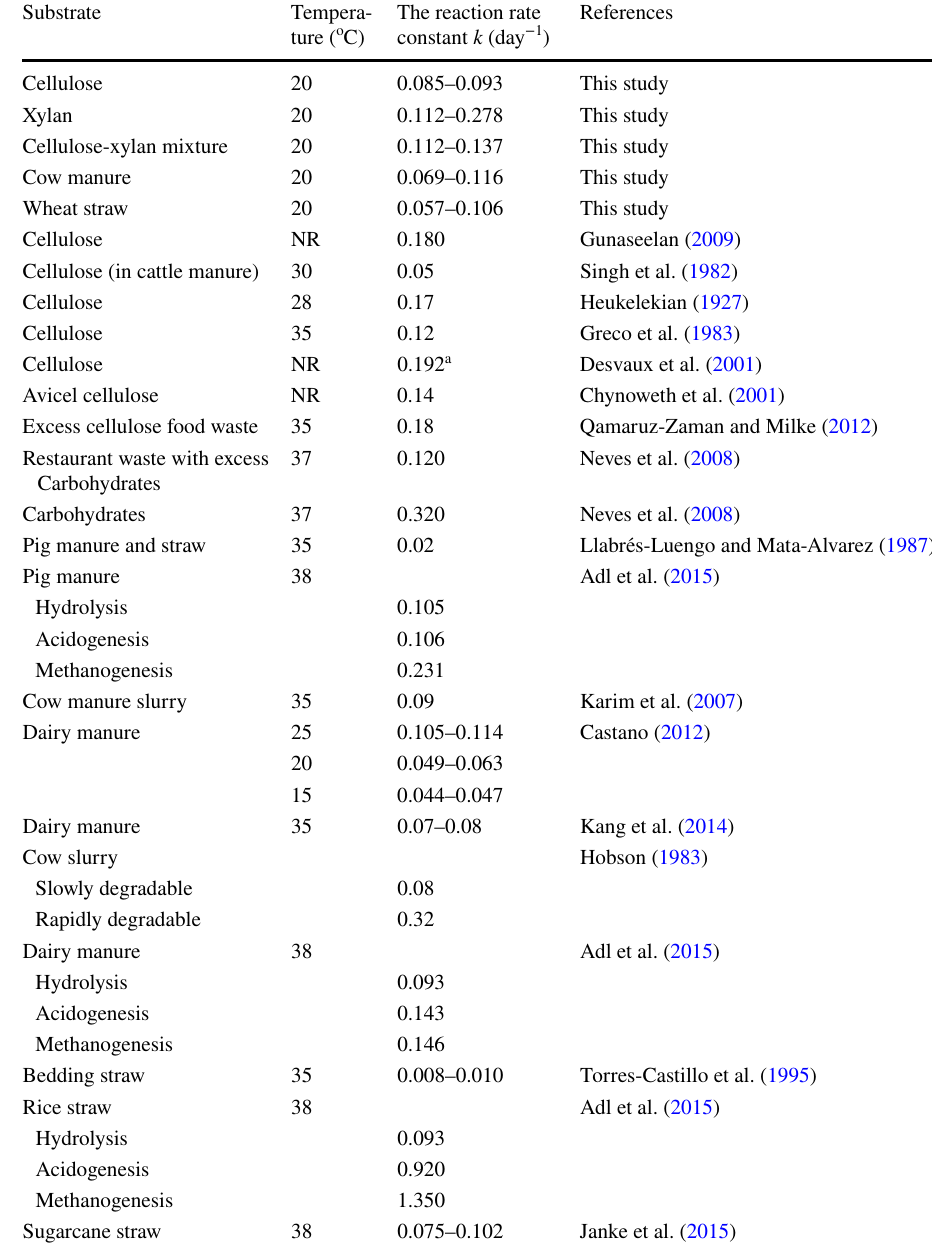
Table 7 The first-order reaction rate constants of methane production for lignocellulosic